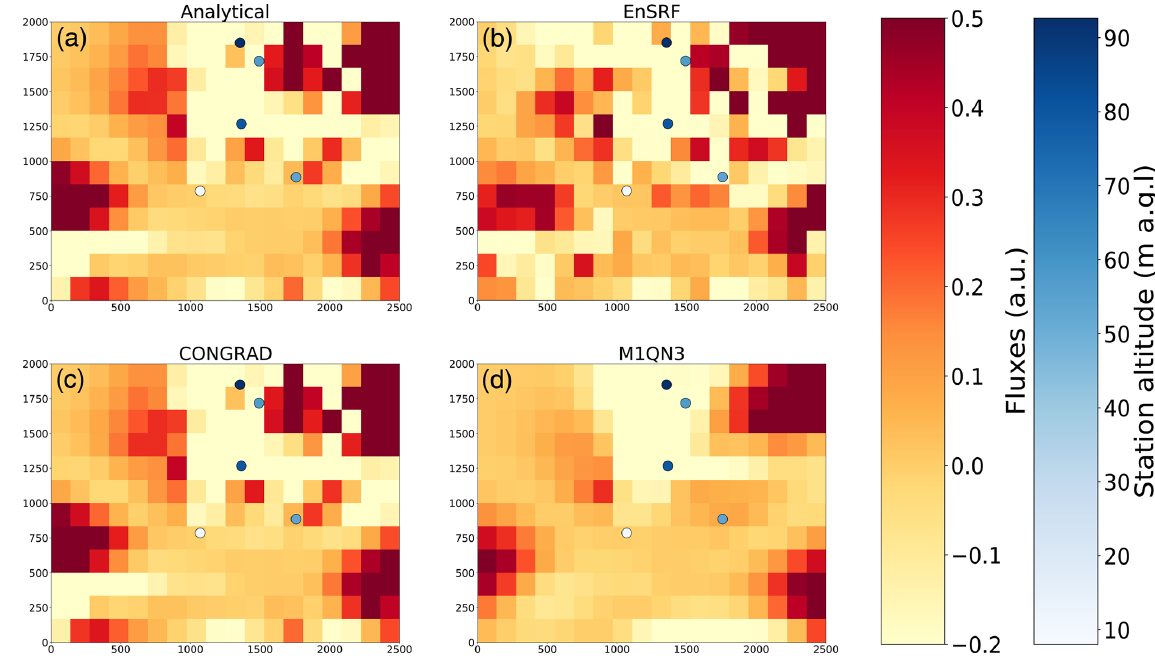
Figure 5. Posterior increments for analytical, EnSRF, variational with CONGRAD and variational with M1QN3 (from top to bottom, left to right) for an inversion set-up at the pixel resolution with horizontal correlation length of